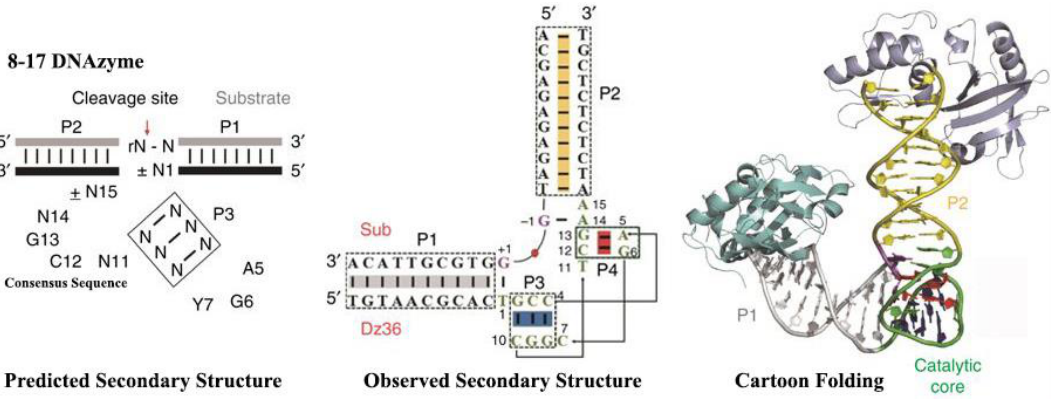
Figure 2. The global architecture of the 8 – 17 DNAzyme, including the predicted secondary structure, the observed secondary structure, and a cartoon representation showing the overall fold of the DNAzyme/substrate analog complex. Reprinted with permission from reference [27]. Copyright 2017 Nature publishing group.